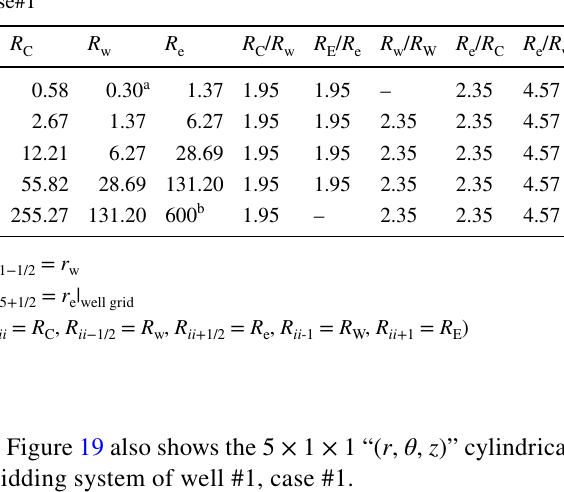
Table 15 Cylindrical gridding system characteristics of